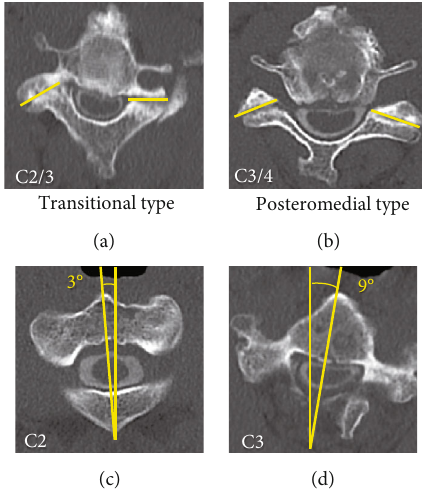
Figure 3: (a) The facet joint of C2/3 was transitional. (b) The facet joint of C3/4 was posteromedial, (c, d) C2 vertebra rotated to the right and to the lower vertebra.